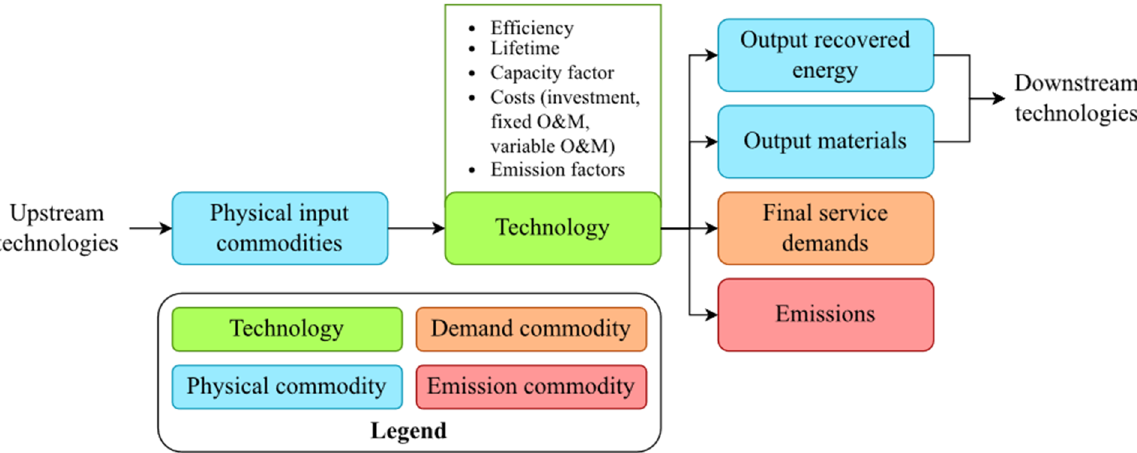
Figure 2. Schematic representation of the different commodity categories in the RES construction.